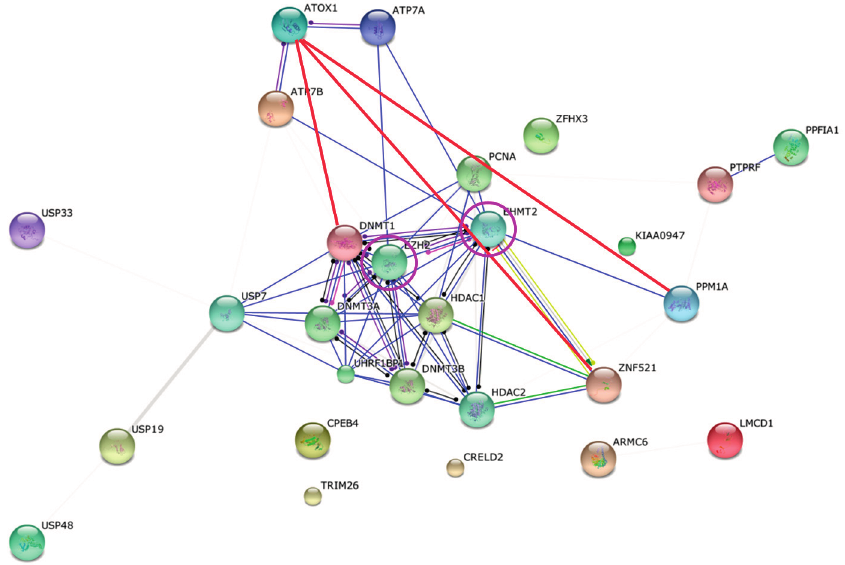
Figure 2. Predicted interaction network for Atox1 and the confident hits based on String analysis (all arrows except the red lines). Atox1 interacts with ATP7A/B, as found in the current screen and in its normal Cu transport function and also predicted by String. Three Atox1 interaction partners from the screen (red lines; ZNF521, PPM1A, DNMT1) as well as ATP7A/B were proposed by String to interact with the proteins EZH2 and/or EHMT2 (purple circles). These interactions create closed networks linking Atox1 to the three screen hits also via the ATP7A/B and EZH2/EHMT2 connections. None of the other although the confident level was set to